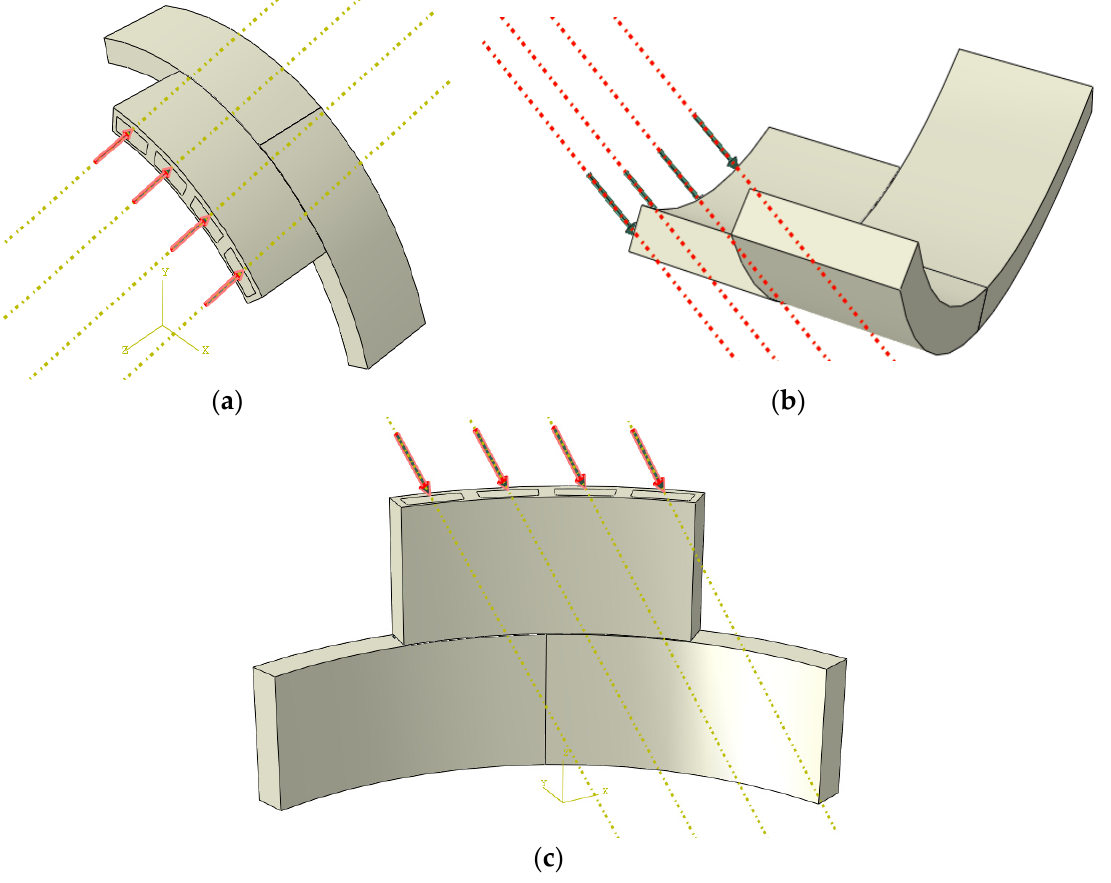
Figure 5. Assembly error of segment: ( a ) inward deflection; ( b ) outward deflection; ( c ) lateral deflection. (Take the assembly of one segment as an example.)